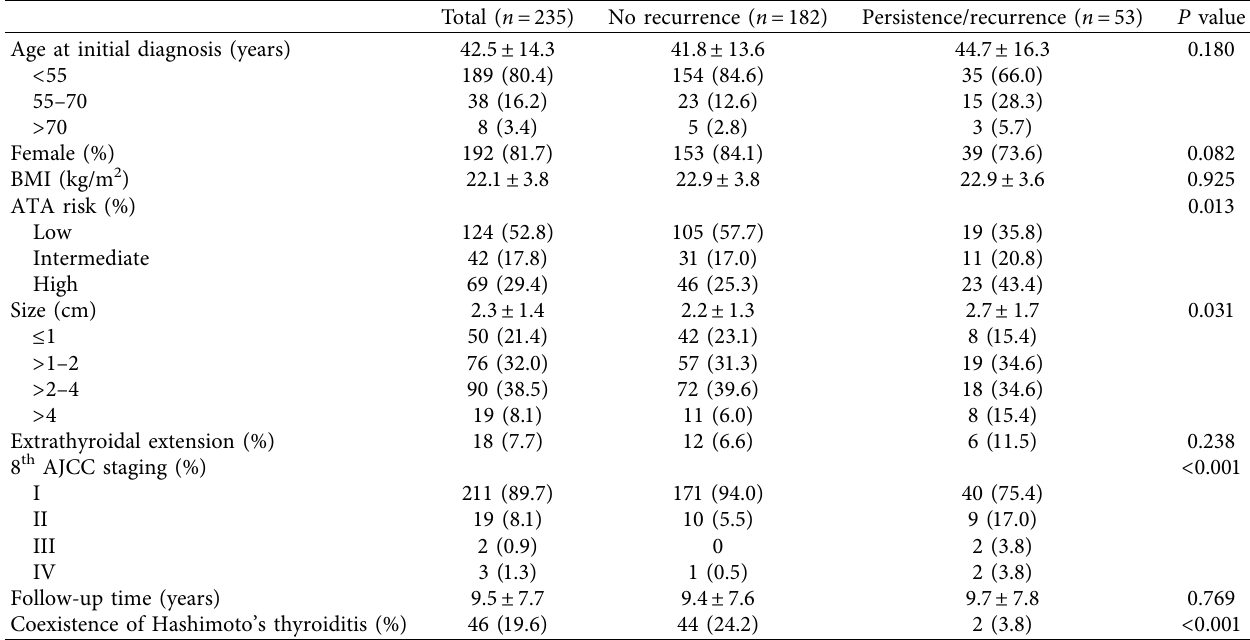
Table 1: Demographic data of 235 papillary thyroid cancer patients.